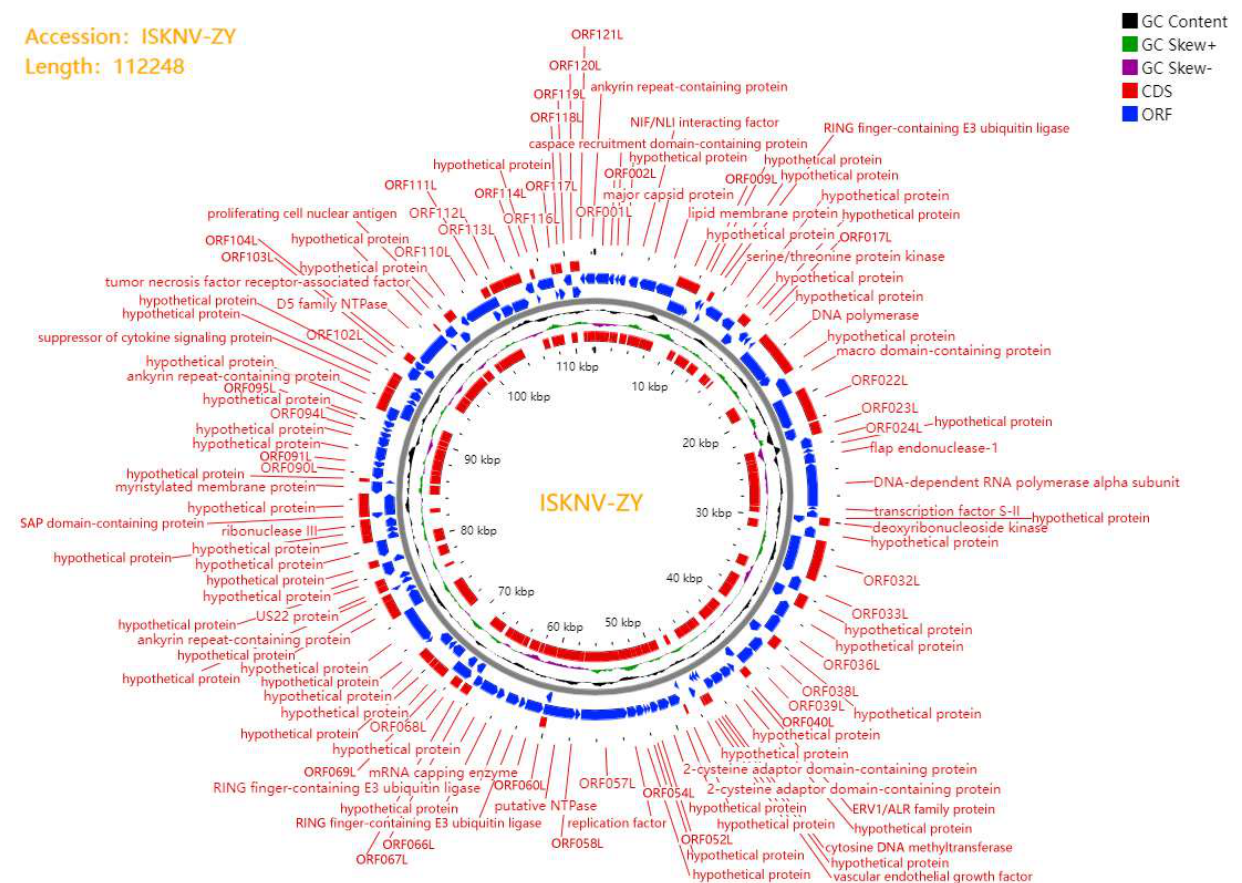
Figure 2. Infectious spleen and kidney necrosis virus (ISKNV)-ZY genome circle mapping using the Proksee online software (https://proksee.ca/, 7 January 2023). The orange portion denotes the predicted open reading frames (ORFs), with the arrow direction indicating the approximate size and transcription direction of the ORFs (https://www.ncbi.nlm.nih.gov/orffinder/, 7 January 2023). The blue part is the CD information subjected to a homology search using the NCBI BLASTp (https://blast.ncbi.nlm.nih.gov/Blastp, 7 January 2023) program. The circle diagram also shows the CG content and CG Skew distribution of the genome.